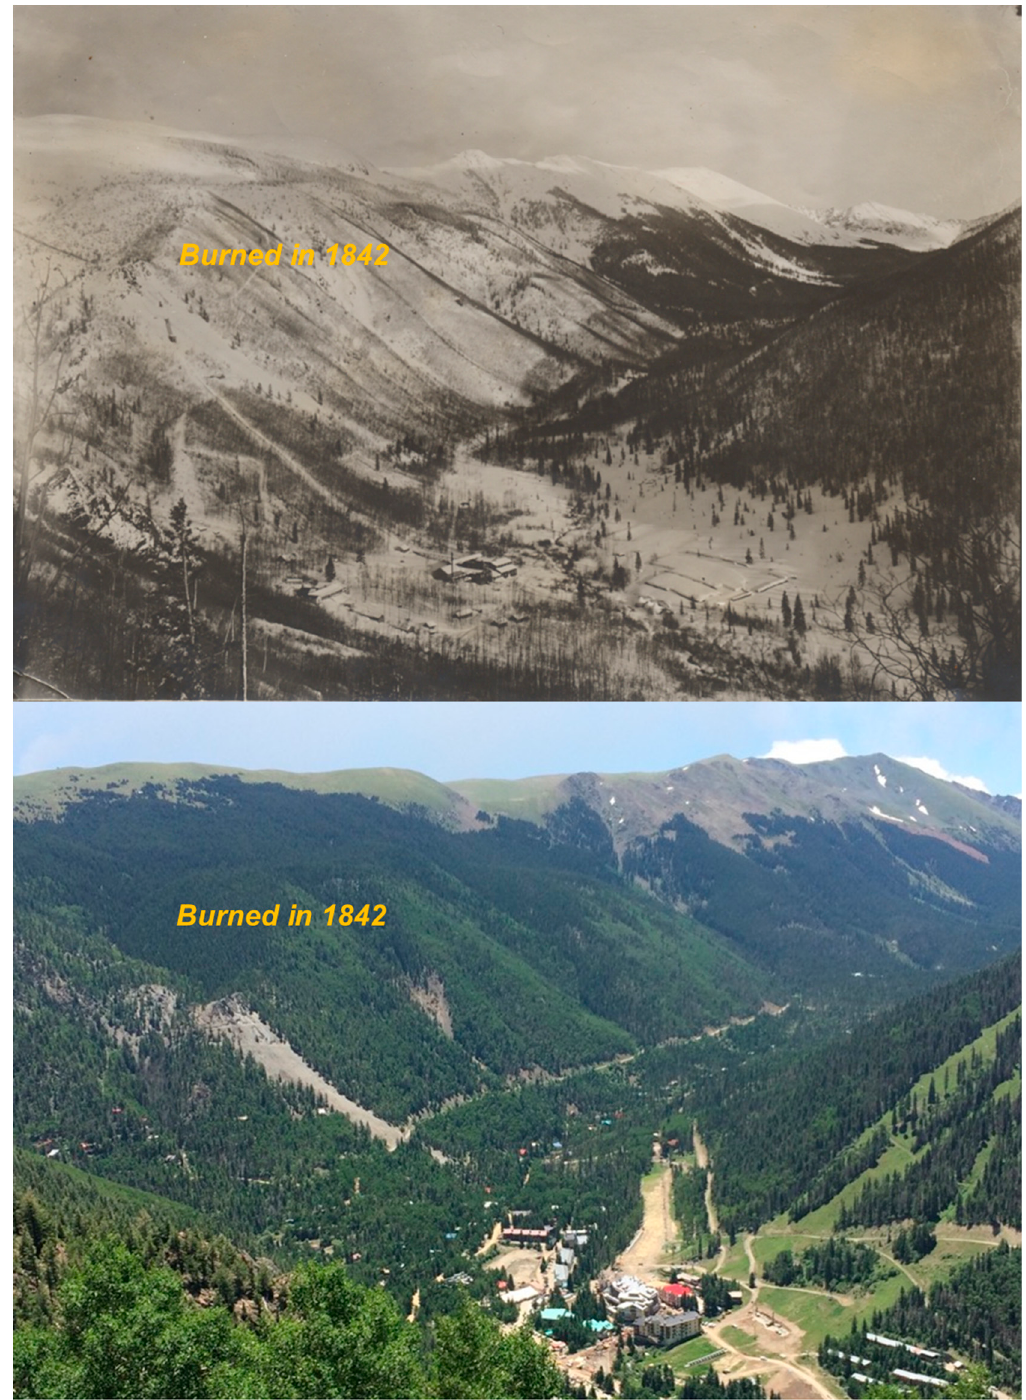
Figure 10. Repeat photographs looking southeast from 1903 ( top ) and 2016 ( bottom ) of the upper Rio Hondo watershed that burned in a high-severity fire in 1842. The visible burned area includes forest-age plots RHD, E, and F and was taken near plot RHK. Today, the valley is home to Taos Ski Valley and the associated community. The historical image is courtesy of Mickey Blake and Taos Ski Valley Inc., Image no. TSV-1050A. The 2016 photo was taken by Charles Mogen. See Figure 7 for the photograph location and direction. Figure 9 is a close-up of the southern end of the burned (aspen-covered) area.